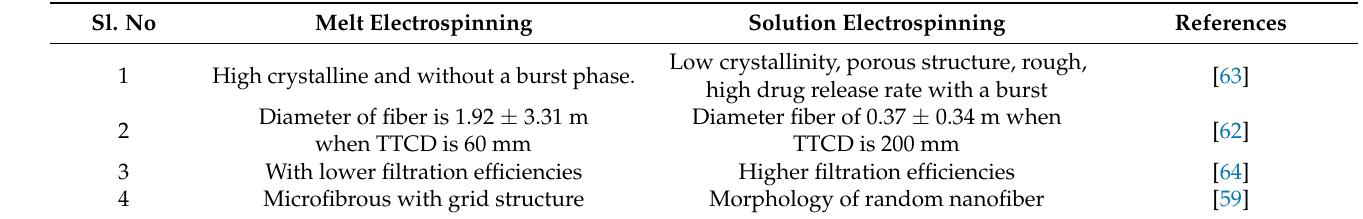
Table 8. Comparison of of Drug Release Using Melt Electrospinning and Solution Electrospinning